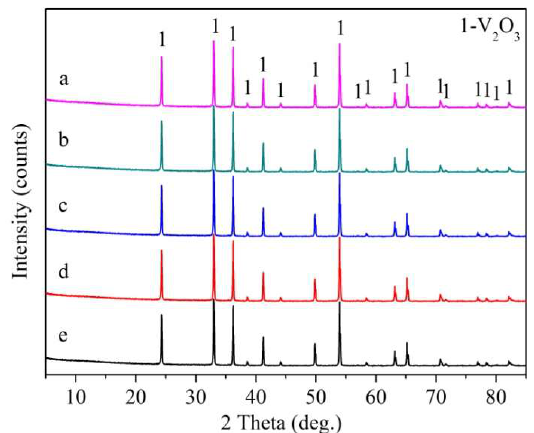
Figure 4. X-ray diffractometer (XRD) patterns of the precipitates obtained at different sodium ions concentrations of ( a ) 22.95 g/L; ( b ) 34.25 g/L; ( c ) 46.23 g/L; ( d ) 57.55 g/L, and ( e ) 68.87 g/L in the feed solutions.